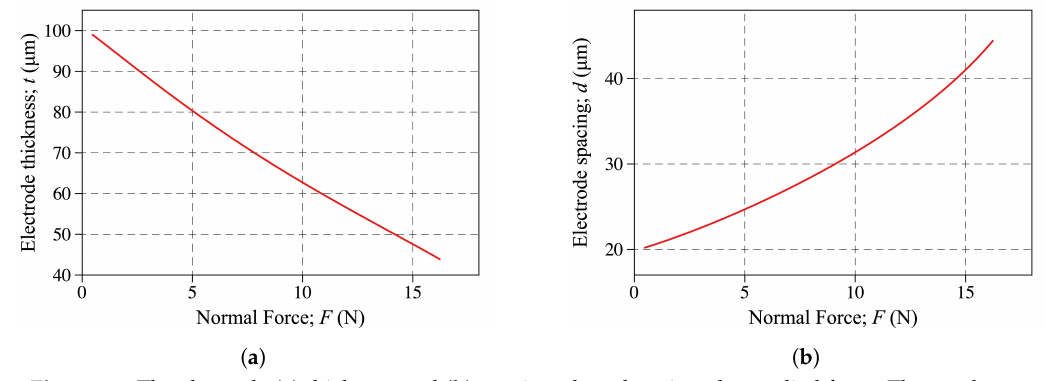
Figure 13. The electrode ( a ) thickness and ( b ) spacing plotted against the applied force. The results are obtained using the model developed in this study i.e., Equations (13) and